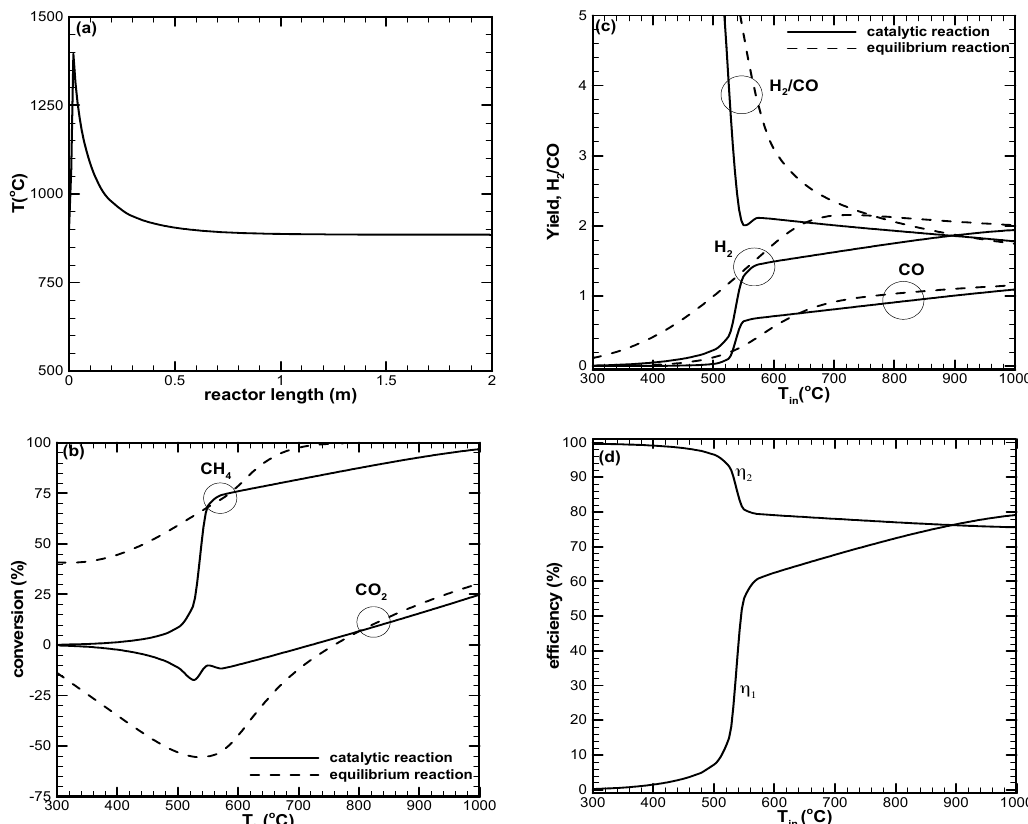
Figure 3. Performance of tri-reforming (TR) process obtained using the base operation conditions listed in Table 1. ( a ) Temperature variation along reactor with T in = 900 °C; ( b ) CH 4 and CO 2 conversions; ( c ) H 2 yield, CO yield, and H 2 /CO ratio; and ( d ) First- and second-law efficiencies.